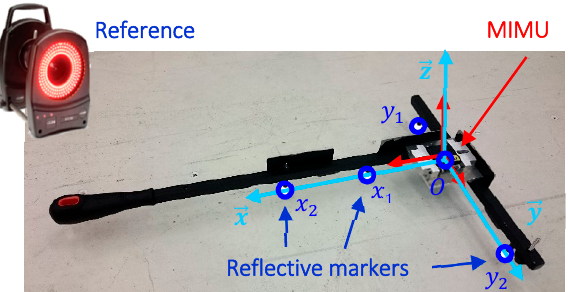
Figure 1. Set square equipped with both an MIMU and five reflective markers. The reflective markers can be used to define local coordinate systems associated with the set square.